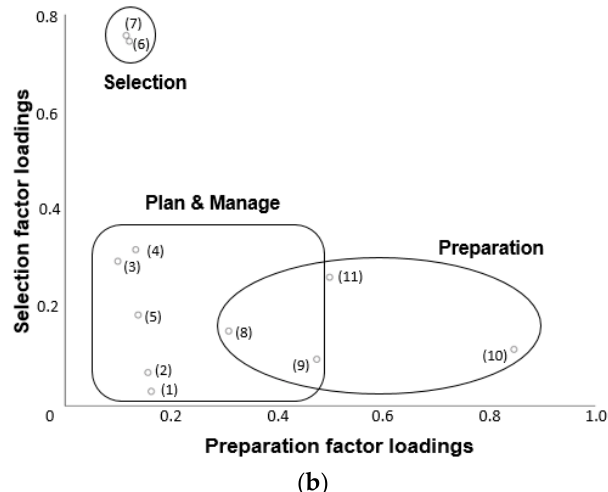
Figure 1. 2-Dimensional plots of the three food literacy behaviours factors and the factor loadings of the items ( a ) Plan & Manage and Preparation and ( b ) Selection and Preparation.